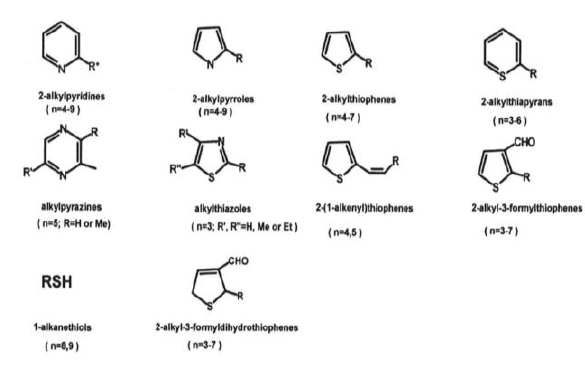
Table 5. Occurrence of some long-chain alkylthiazoles in meat